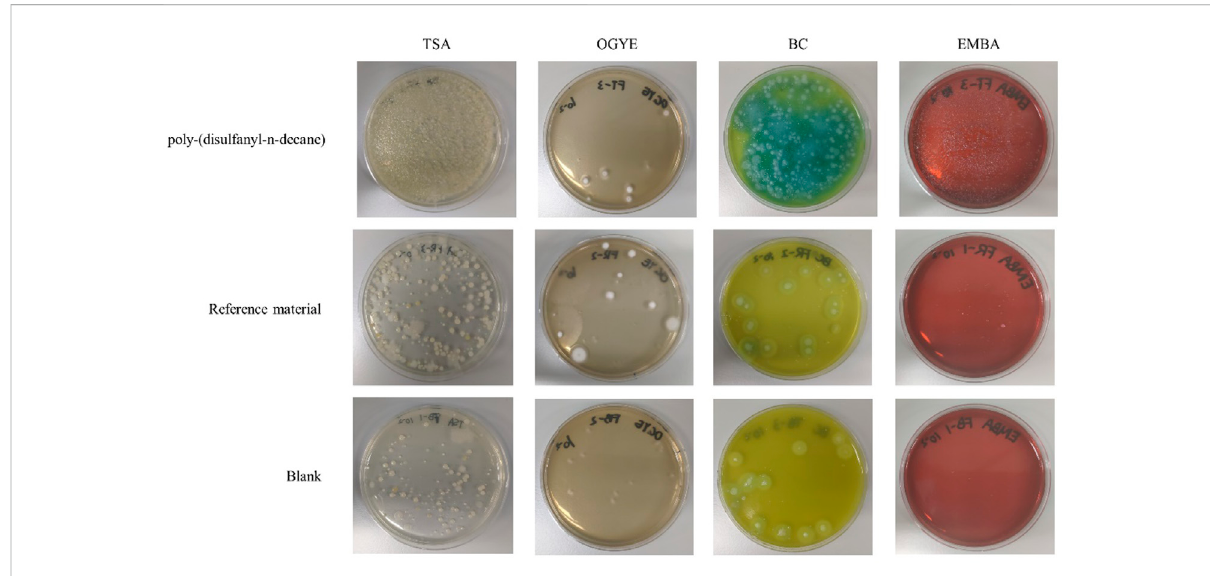
FIGURE 9 Plating of soil mixtures with a dilution of 10 2 in Tryptic Soy Agar (TSA), Oxytetracycline Glucose Yeast Extract (OGYE), Bacillus cereus Agar (BC) and Eosin Methylene Blue Agar (EMBA) in the end of the biodegradability test.